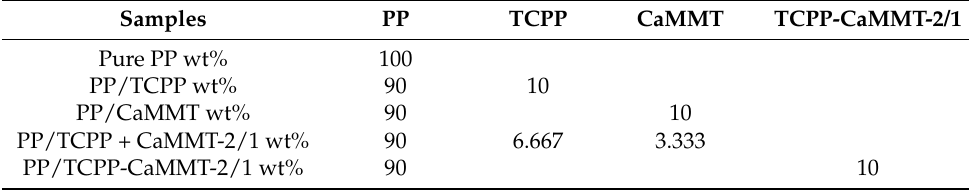
Table 1. Composition of PP